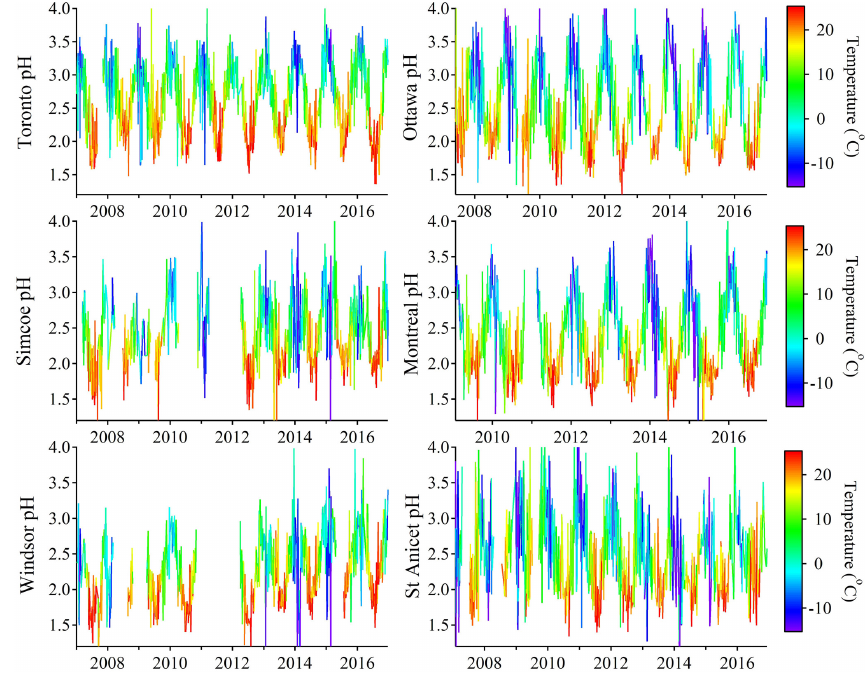
Figure 2. The time series of PM 2 . 5 pH at six sites coloured by ambient